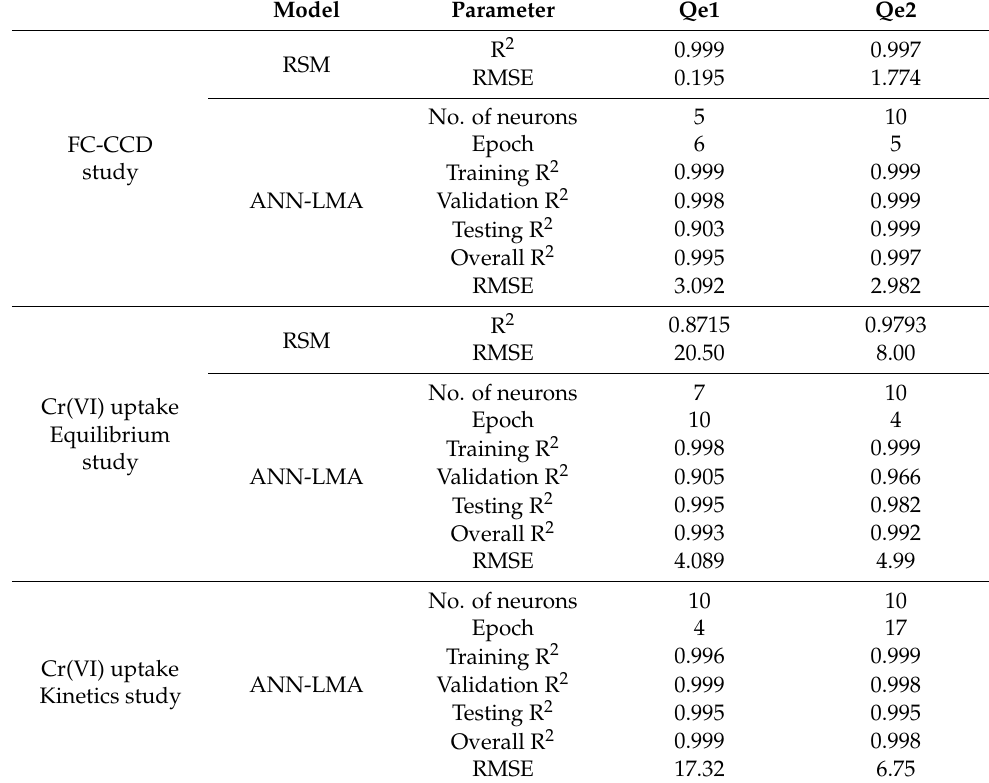
Table 6. ANN-LMA and RSM fitted model parameters for FC-CCD, equilibrium and kinetic studies.